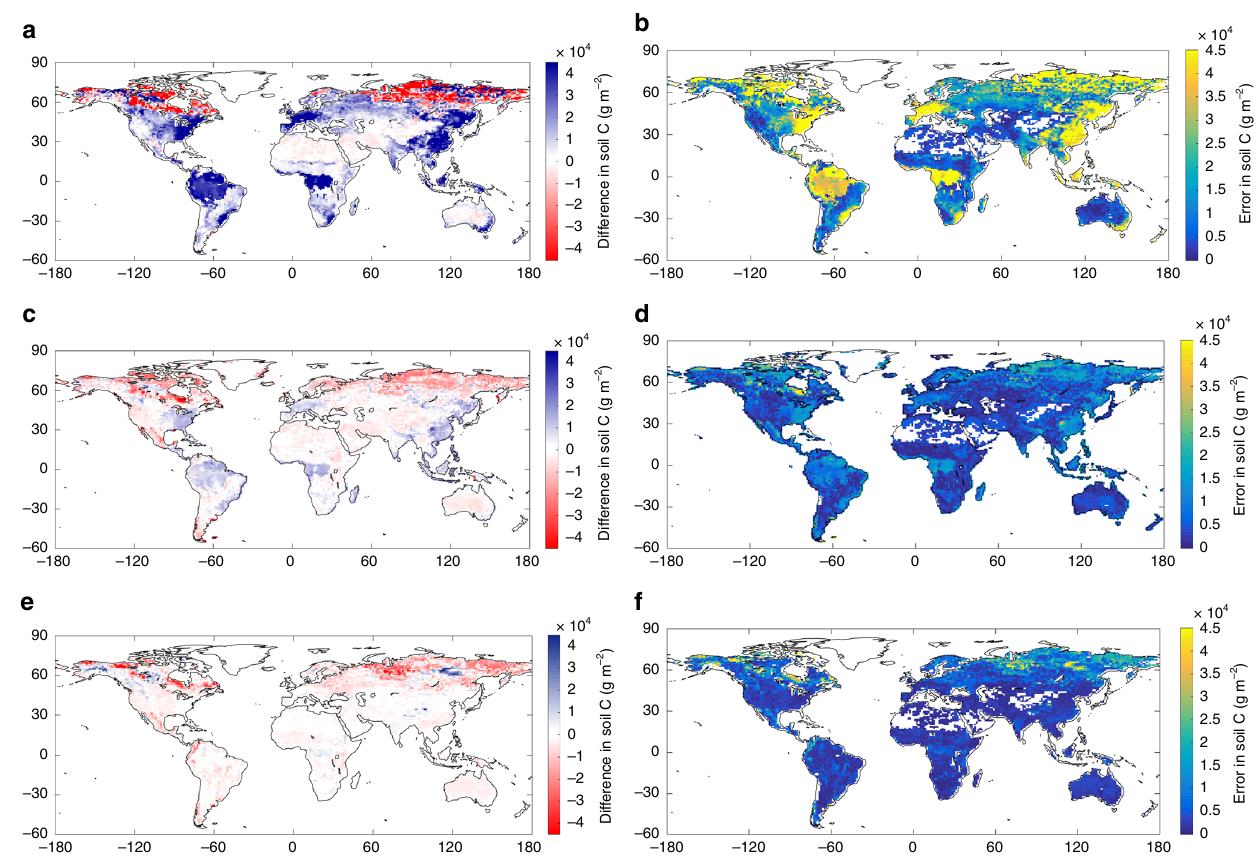
Fig. 3 Difference between estimated mean soil carbon and the soil carbon database. a , b are the difference and root mean squared error in the conventional model, respectively; c , d are the difference and root mean squared error in the vertically resolved model, respectively; e , f are the difference and root mean squared error in MIMICS, respectively